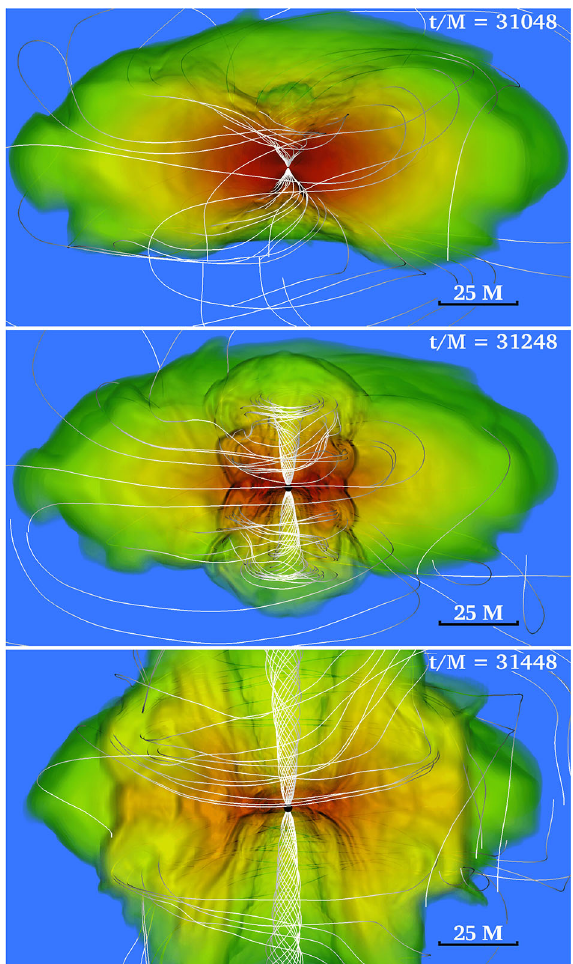
Fig.30 Cutof3Drest-massdensityprofile(coloredvolumerendering)ofamagnetizedrotating,collapsing supermassive star with magnetic-field lines indicated by white curves. The top panel corresponds to the time near BH formation, the middle panel is during the development of the incipient jet, and the bottom panel shows the fully developed incipient jet. (Image reproduced with permission from Sun et al. 2017, copyright by